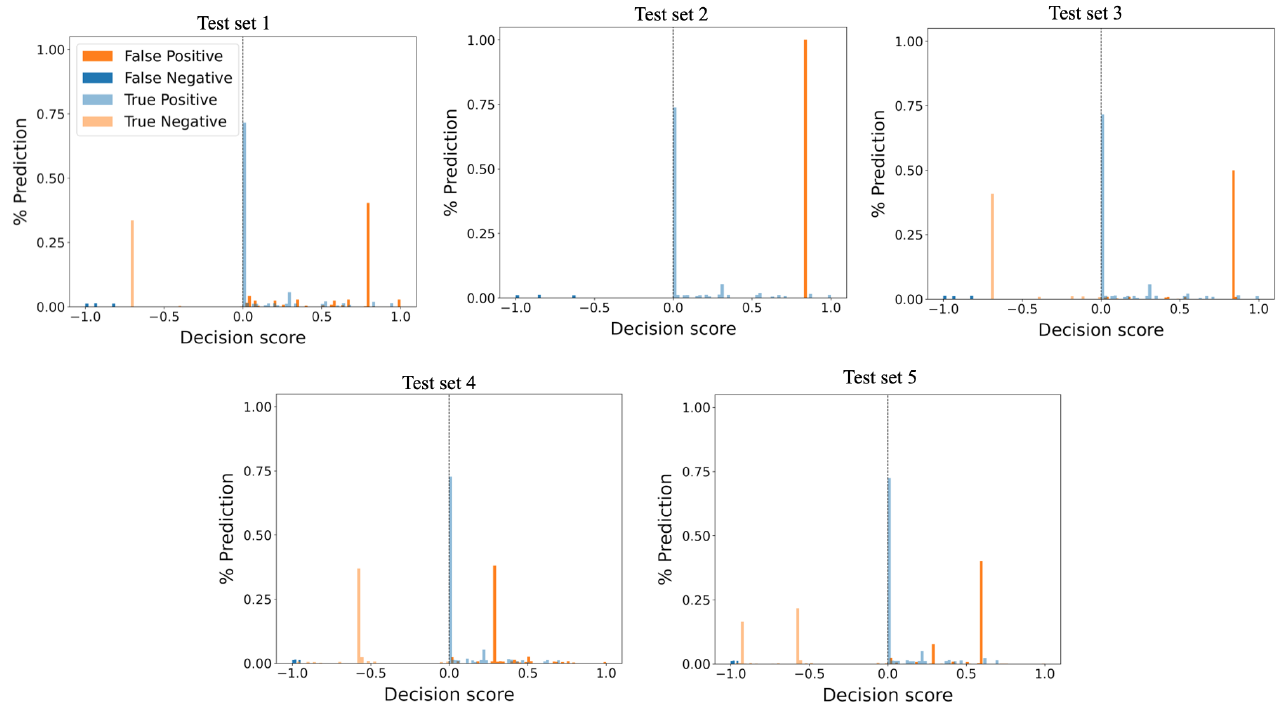
Figure 6. OCSVM results of the normalized TP, TN, FP, and FN values on test sets